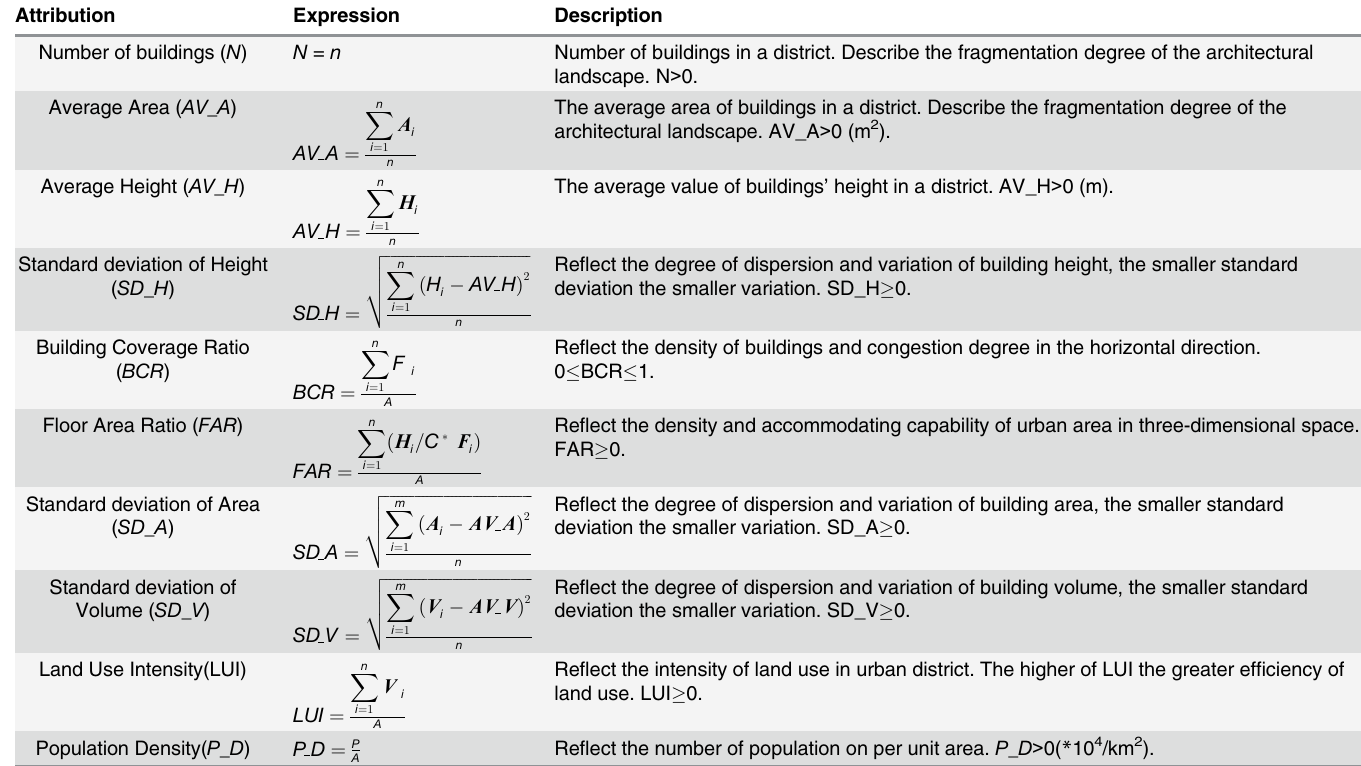
Table 1. Index of terms and their meanings. Attribution Expression